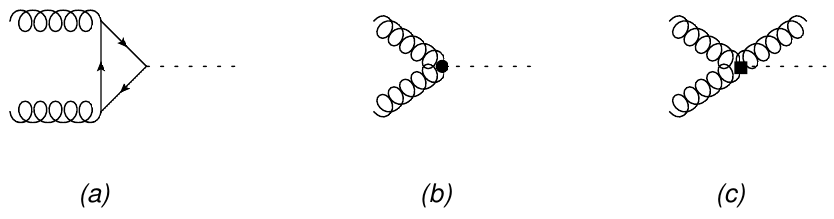
Figure 5 . (a) Leading order diagram for the production of a Higgs boson via gluon fusion; (b) Contact interaction in the large top mass limit; (c) Contact interaction for radiation of an extra